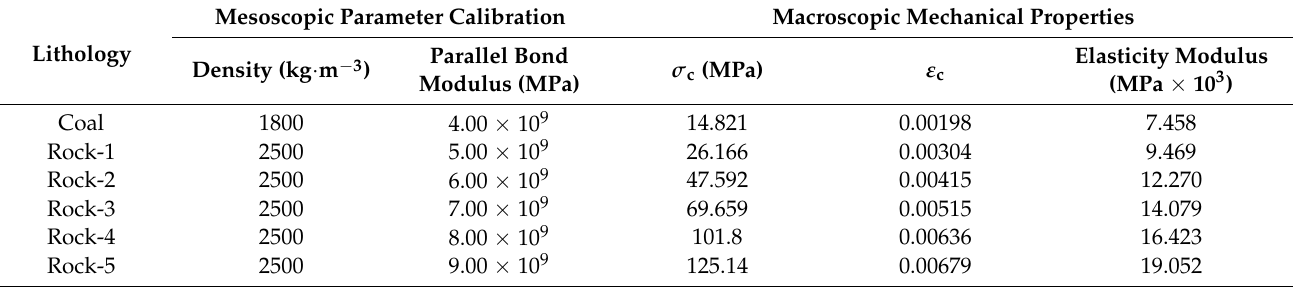
Table 1. Mesoscopic mechanical parameters of coal and rocks.